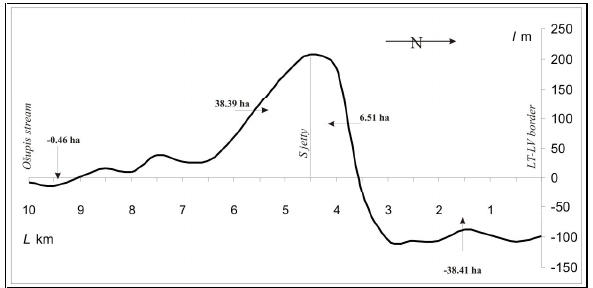
Fig. 4. Coastline changes in the area of Šventoji port from 1910 to 2010. 0 of X-axis identifies the coastline condition in